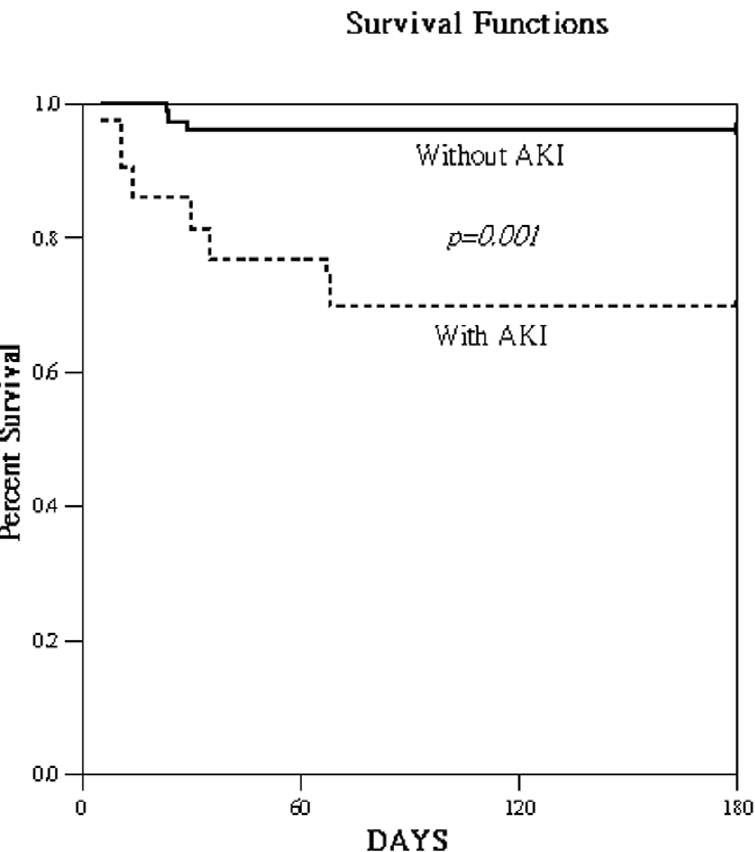
Figure 1. Cumulative survival rate for 150 critically ill patients based on with/without acute kidney injury (AKI) at 48-hour after coronary care unit admission.